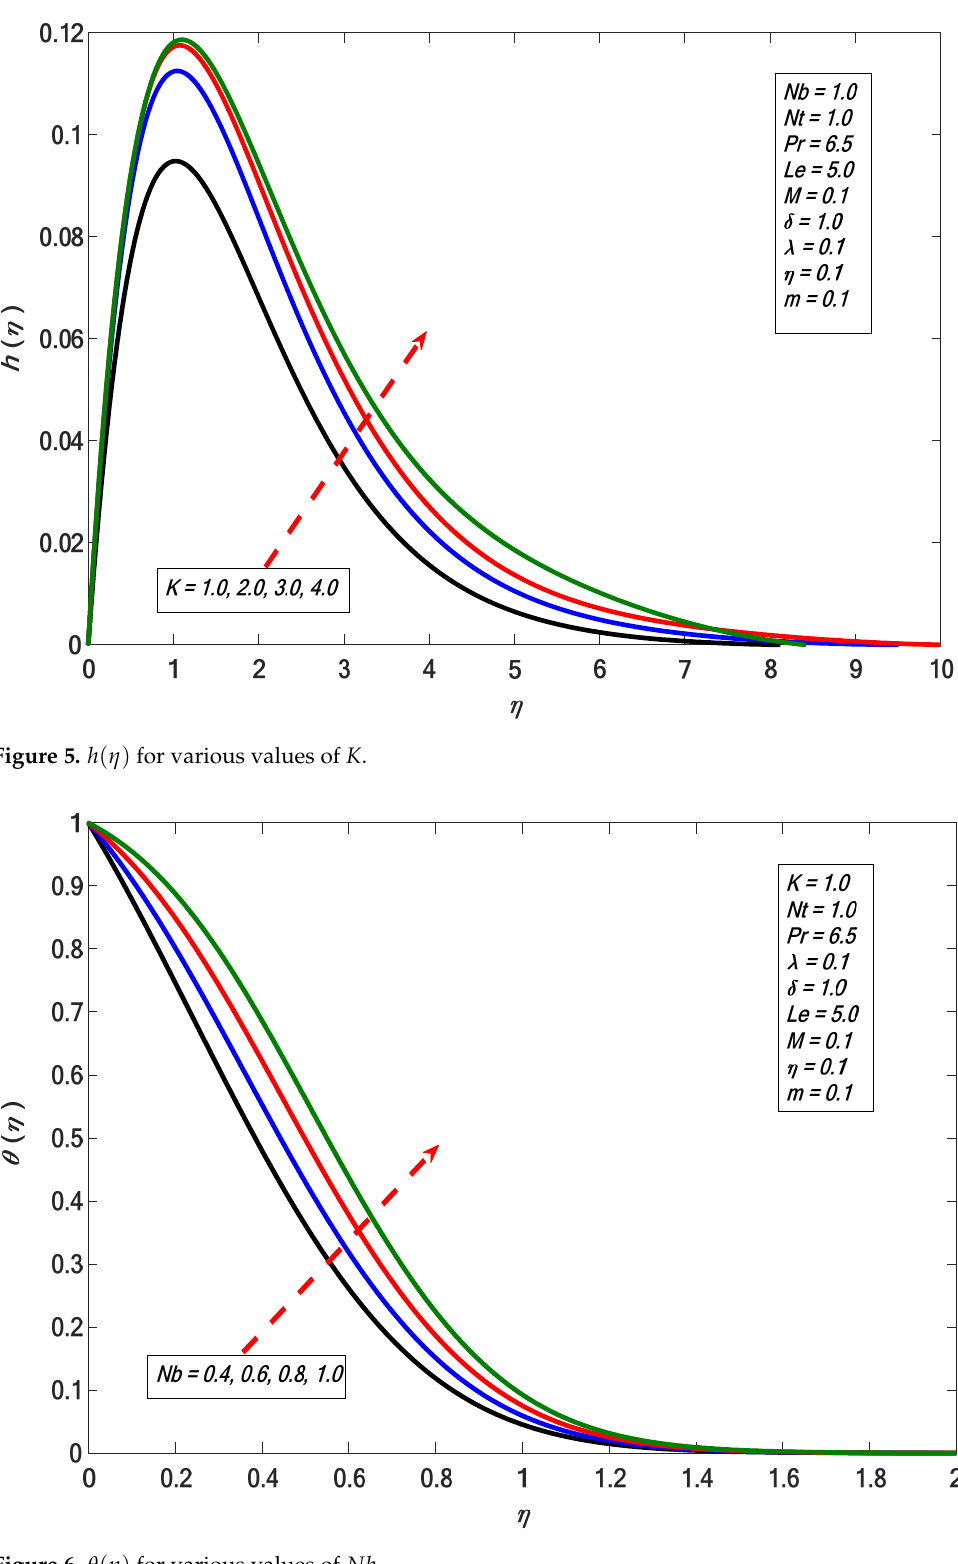
Figure 7. 𝜃(cid:4666)𝜂(cid:4667) for various values of 𝑁𝑡.